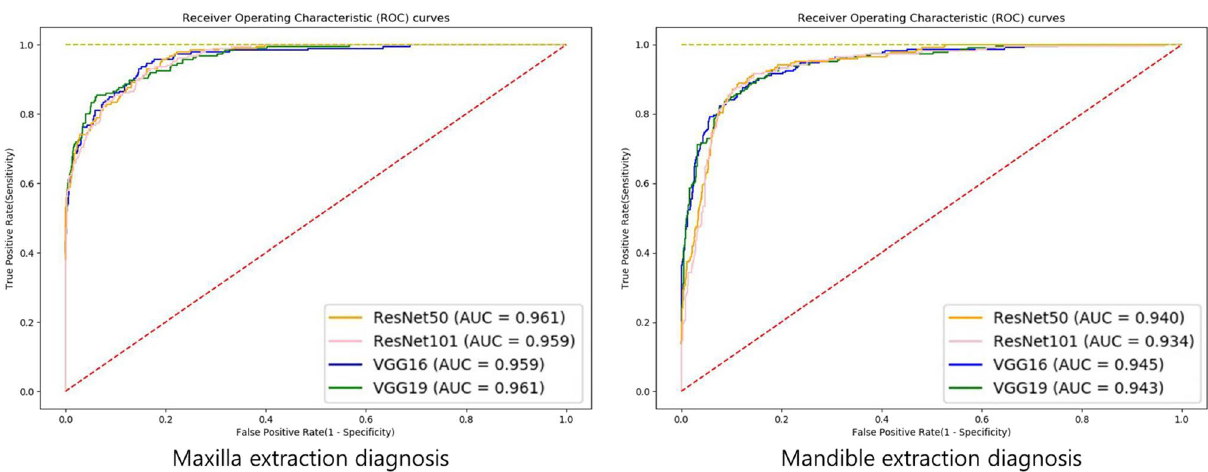
Figure 6. Receiver operating characteristic curves show that all models resulted in high